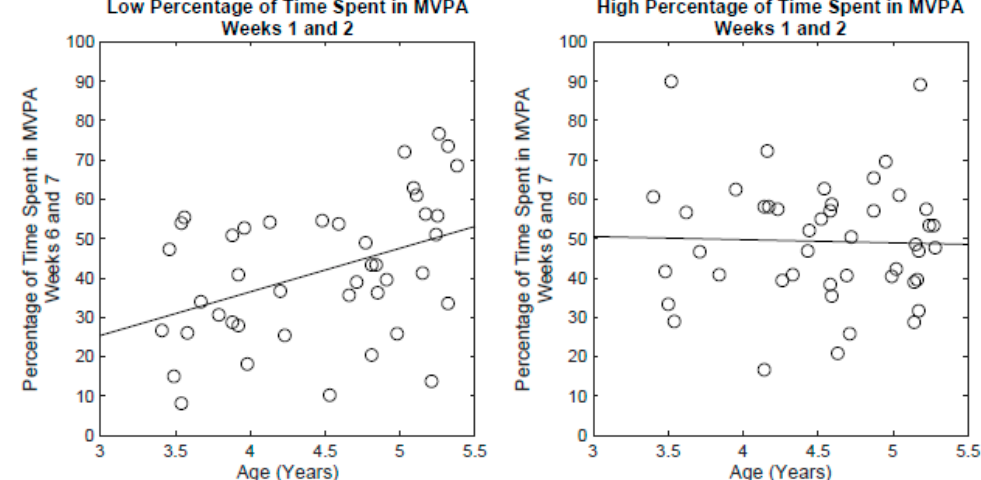
Figure 3. Left: Percentage of time spent in MVPA for weeks 6 and 7 by age for the participants with less than 35% time spent in MVPA for weeks 1 and 2. Each circle represents a participant. The line depicts the fitted regression. Right: Percentage of time spent in MVPA for weeks 6 and 7 by age for the participants with 35% or more time spent in MVPA for weeks 1 and 2. Each circle represents a participant. The line depicts the fitted regression.